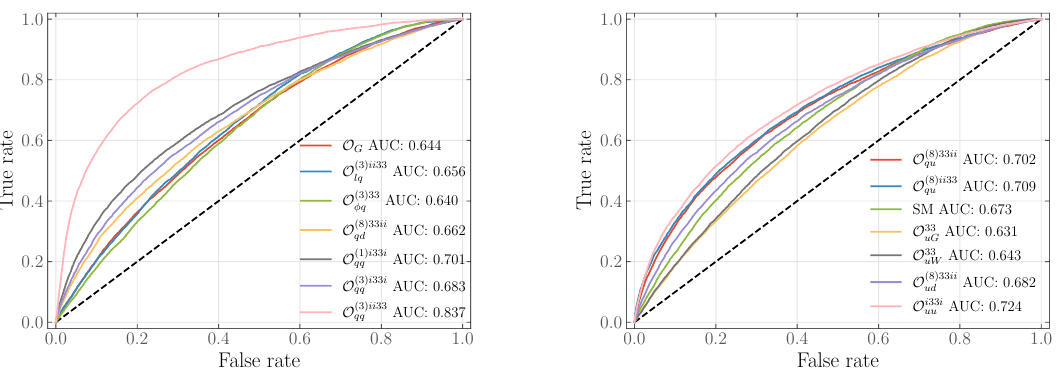
Figure 6 . ROC curves for the scenario where multi-class classification is performed on thirteen SMEFT operators and the